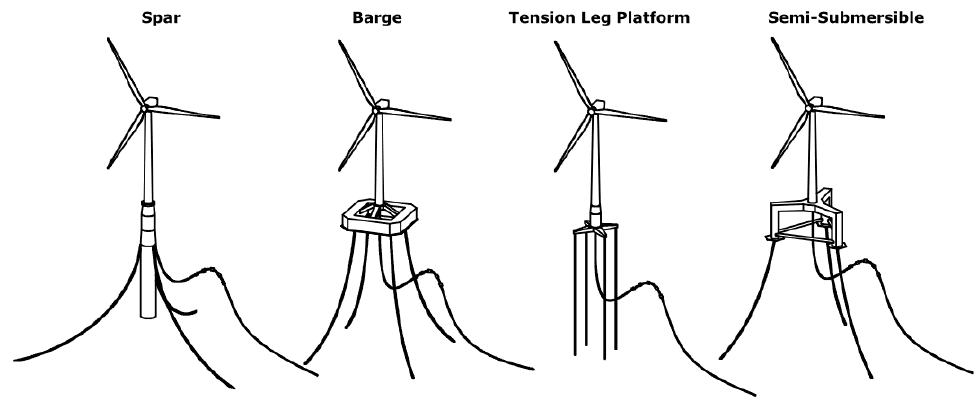
Figure 7. FOWT substructure design classes (reproduced from Ref. [85], this is an open-access article distributed under the terms of the Creative Commons CC-BY license, which permits unrestricted use, distribution, and reproduction in any medium, provided the original work is properly